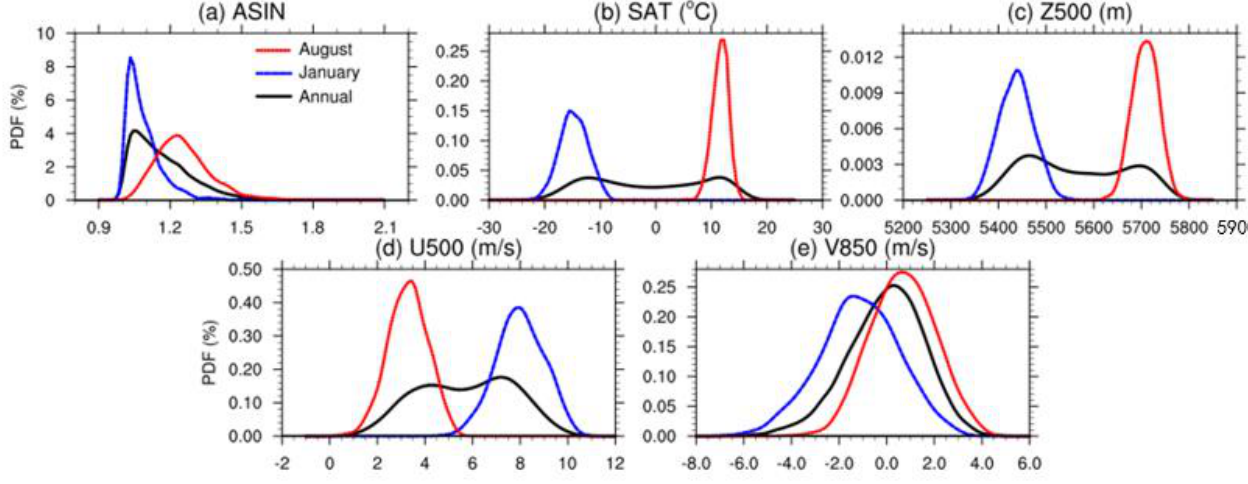
Figure 2. Probability density functions (PDFs) of ( a ) ASIN, ( b ) SAT (°C), ( c ) Z500 (m), ( d ) U500 (m / s), and ( e ) V850 (m / s) in the “large” domain. The three curves in each subgraph represent Annual (black), January (blue), and August (red).